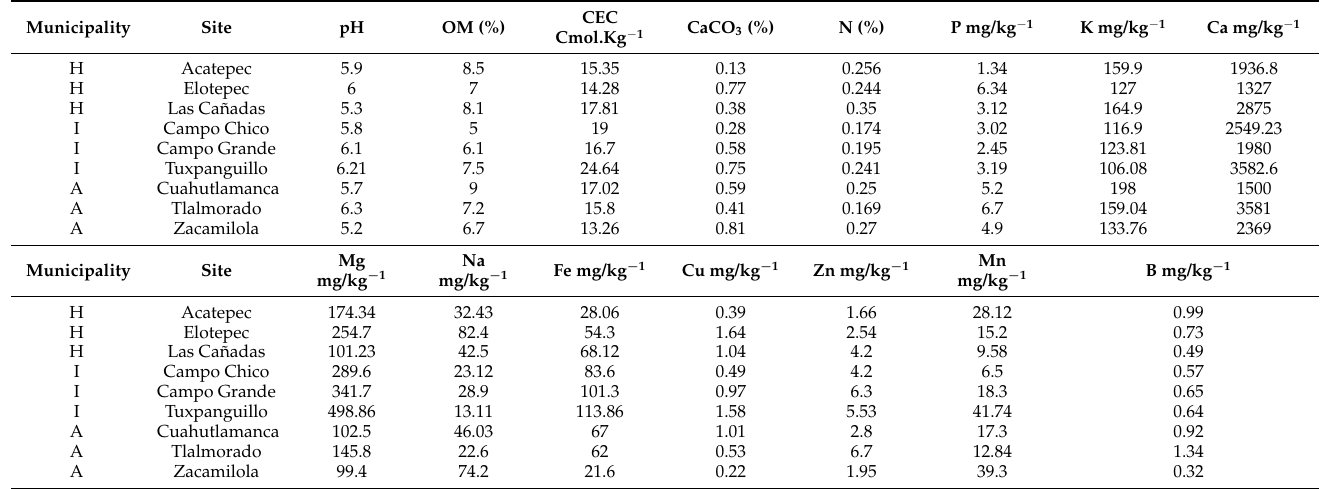
Table 5. Soil analysis of the three natural study populations. Soil analysis of the three natural study populations.